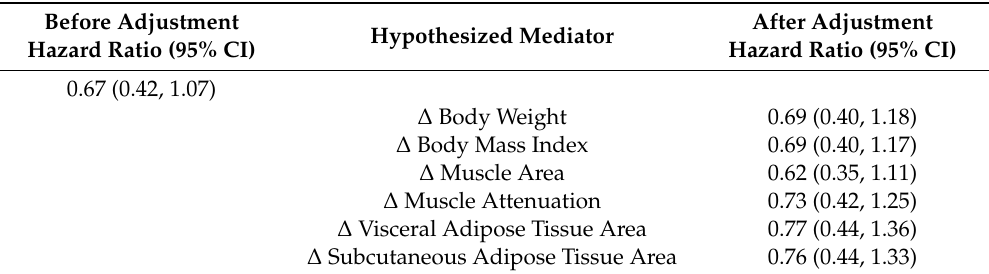
Table 3. Change in e ff ect of vitamin D 3 supplementation randomized group on progression-free survival before and after adjustment for change in body